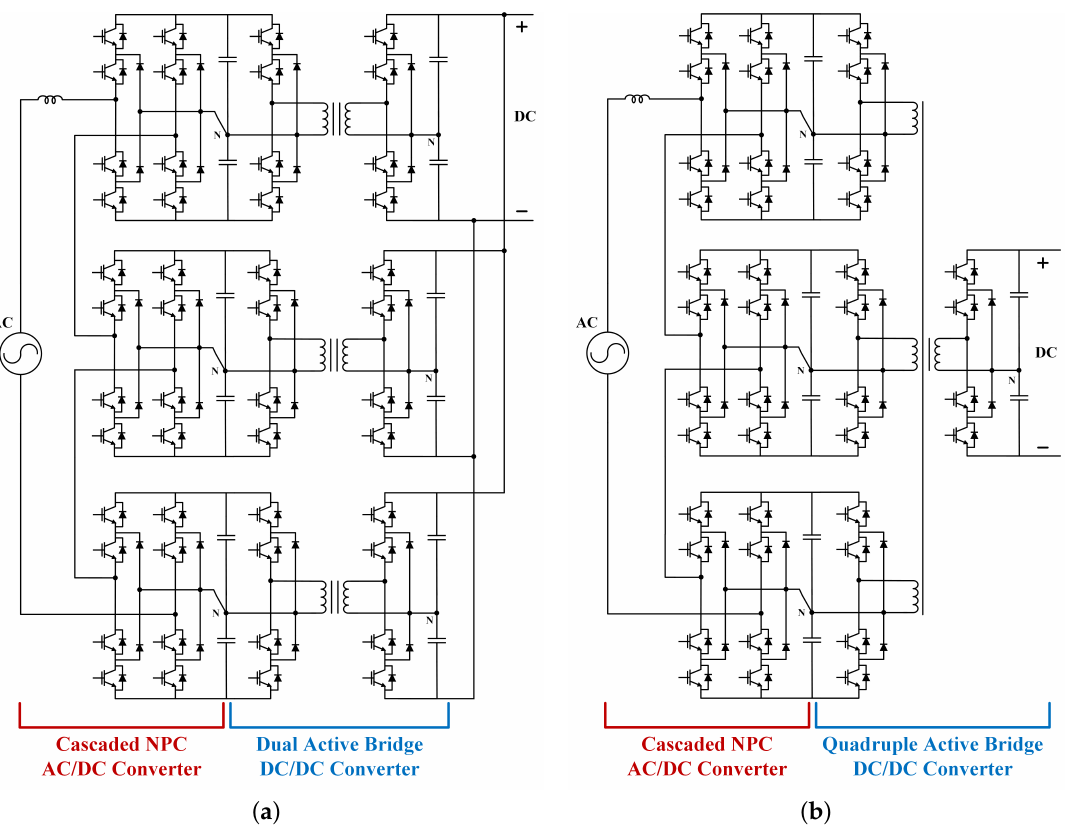
Figure 1. Structure of a unit module: ( a ) the basic structure of an SST combined in a 1:1 ratio using an AC/DC converter and a DAB converter; ( b ) a proposed unit module based on a QAB converter.